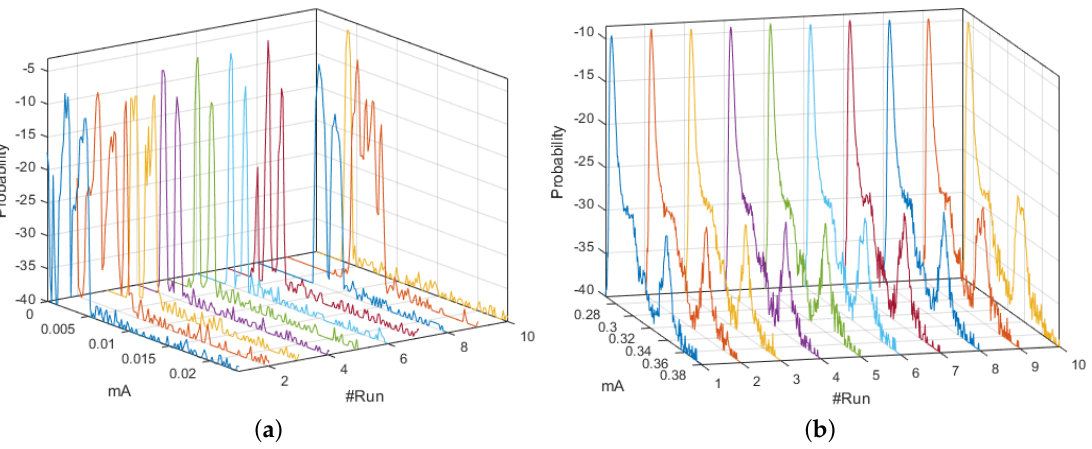
Figure 17. M-mode plots of the pdf with particular characteristics: ( a ) DigiMesh Coordinator Node at 57,600 bauds; and ( b ) WiFi Coordinator Node at 57,600 bauds.